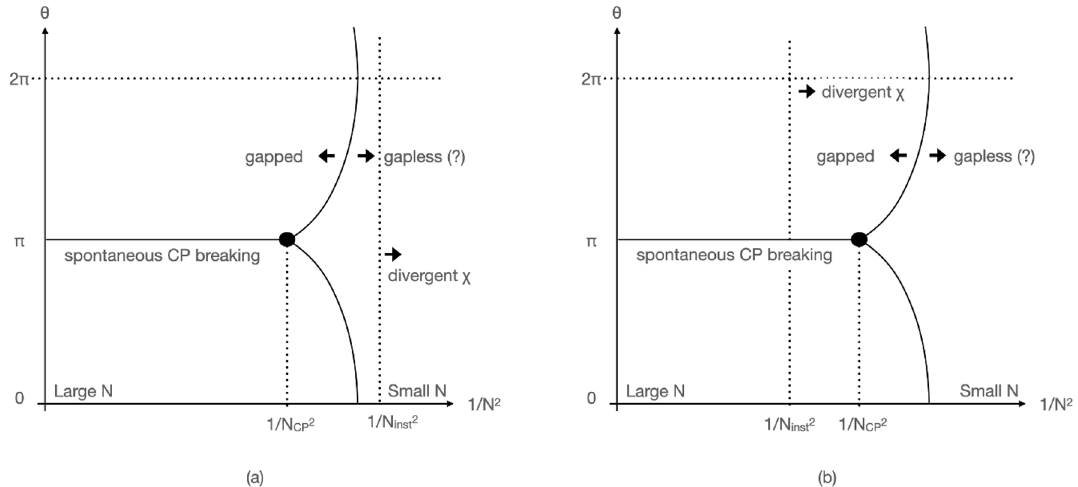
Figure 13 . Possible phase structures of 4d SU( N ) pure Yang-Mills theory as a function of 1 /N 2 and θ . At θ = π and N > N , there is a first-order phase transition. If such N exists, a CP CP gapless theory should be realized for N < N at θ = π . Such a region may extends to θ 6 = π CP as in the figures although it is totally unknown. The topological susceptibility, χ , diverges for N < N inst = 12 / 11 by the contributions from small instantons. In (a) and (b) we show possible phase structures where N and N , respectively. The mixed anomaly in itself inst < N CP inst > N CP allows for more complicated phase structures, and for example allows regions where both CP and center symmetries are